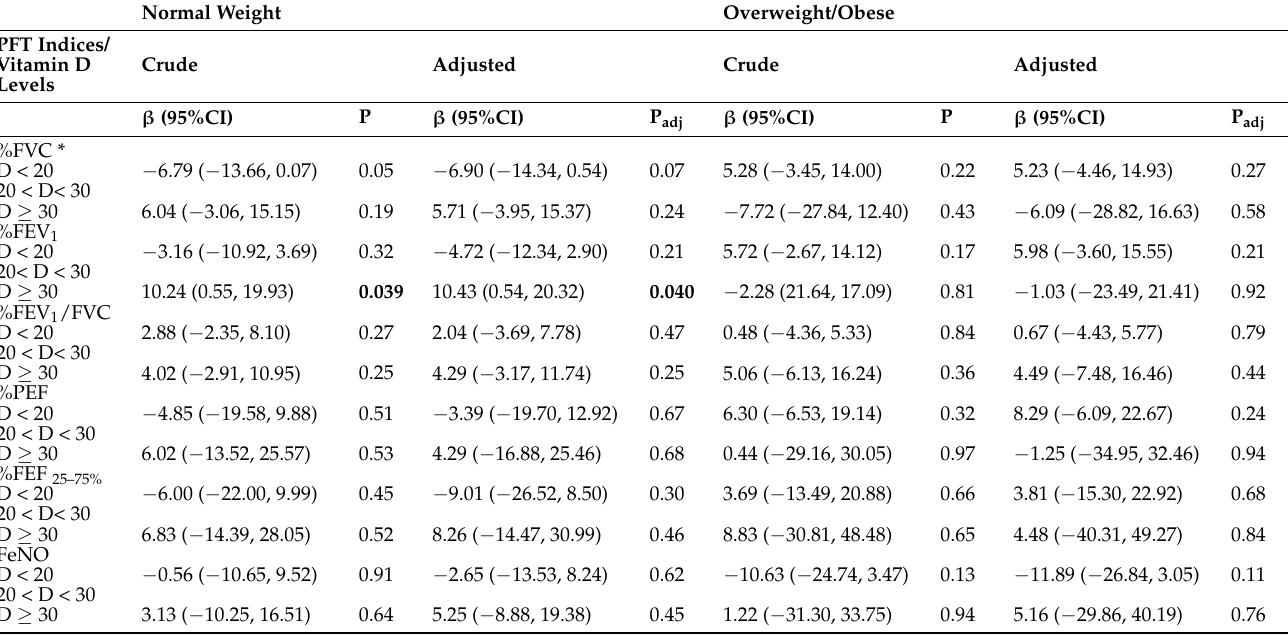
Table 4. Associations between vitamin D levels and pulmonary function tests by BMI